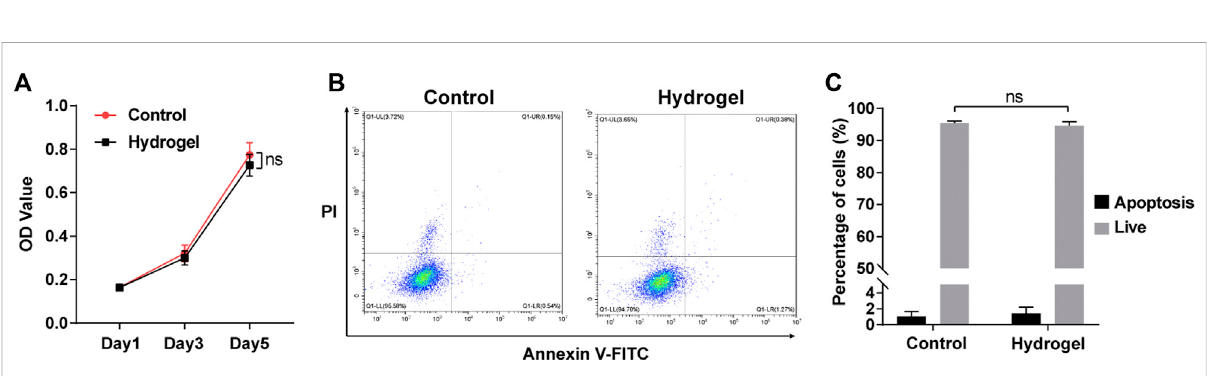
FIGURE 4 Biocompatibility of the adhesive DN hydrogel on N-ADSCs in vitro. (A) The CCK-8 proliferation assay of N-ADSCs seeded with or without the adhesive DN hydrogel. (B,C) Flowcytometry and statistical analysis of the apoptosis rate of N-ADSCs seeded with or without the adhesive DN hydrogel. ns, p > 0.05. N-ADSCs, Netrin-1-modi fi ed adipose-derived stem